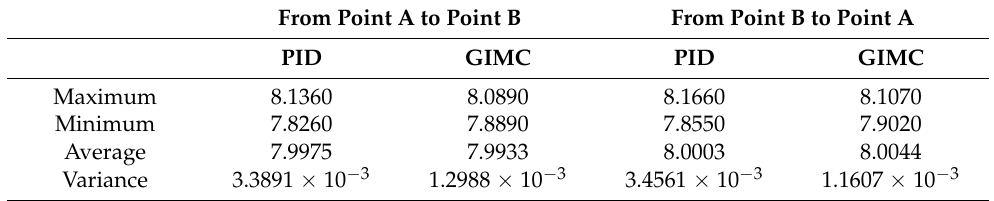
Table 3. Quantitative calculation of experimental results about the suspension gap (Unit: mm). From Point A to Point B From Point B to Point A PID GIMC PID GIMC Maximum